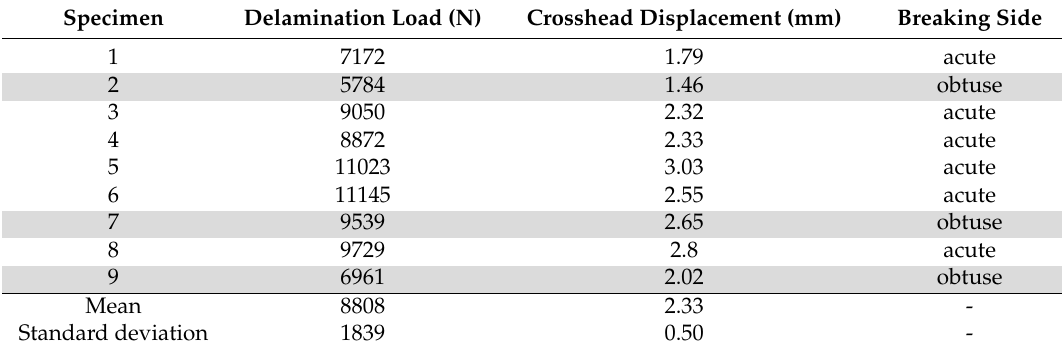
Table 2. T-Pull mechanical test